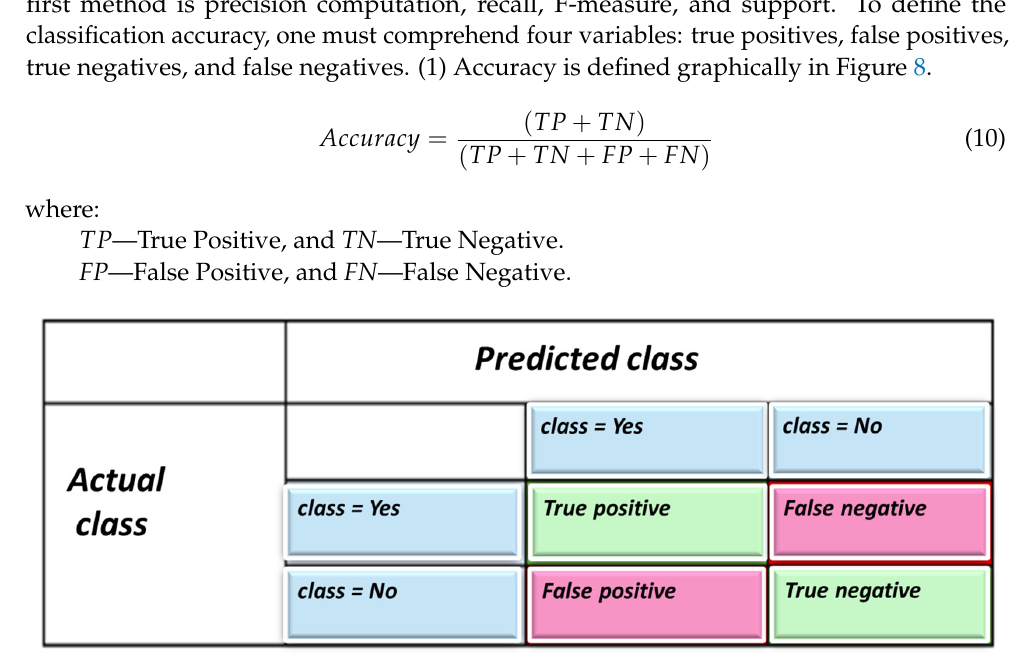
Figure 8. Definitions of four classification outcomes of an AI classification algorithm. (Python uses terminology classes and not objects).